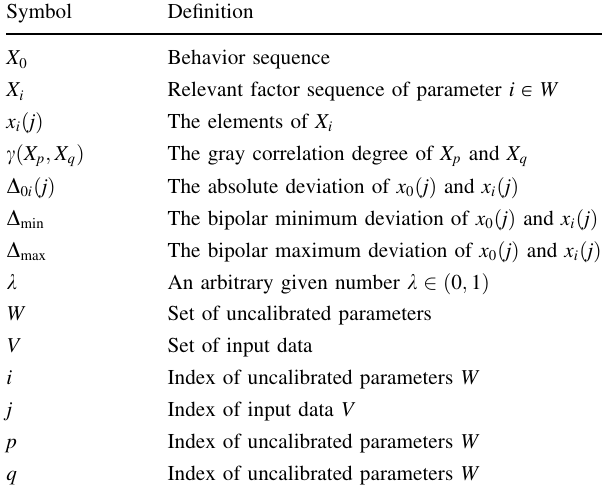
Table 3 Notation for parameter